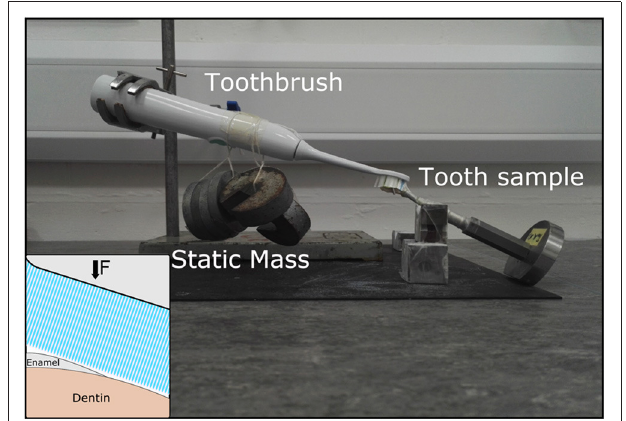
FIGURE 3 | 2D virtual slices of the 3D tomography data captured via XCT. (A) Initial reconstructed slice. (B) Reconstructed slice following application of a NLM denoising filter. (C) The red box highlights the ROI selected for calculating the volume of enamel and dentin. (D) The selected region of interest and the resulting segmented